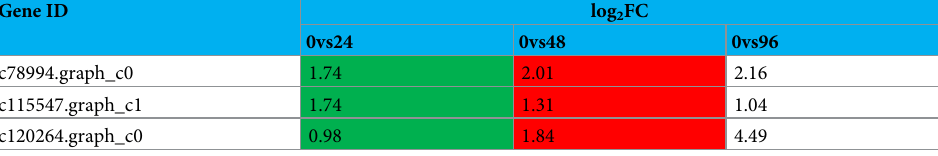
Table 2. Response of the non-specific lipid transfer protein genes to drought stress.